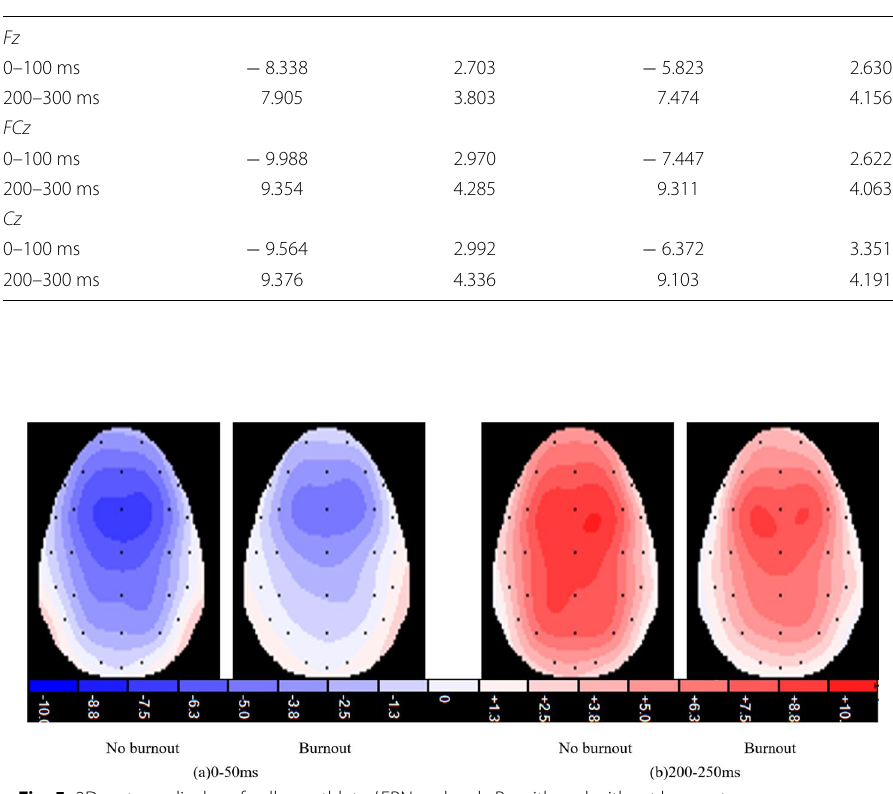
Fig. 5 2D cartoon display of college athletes’ ERN and early Pe with and without